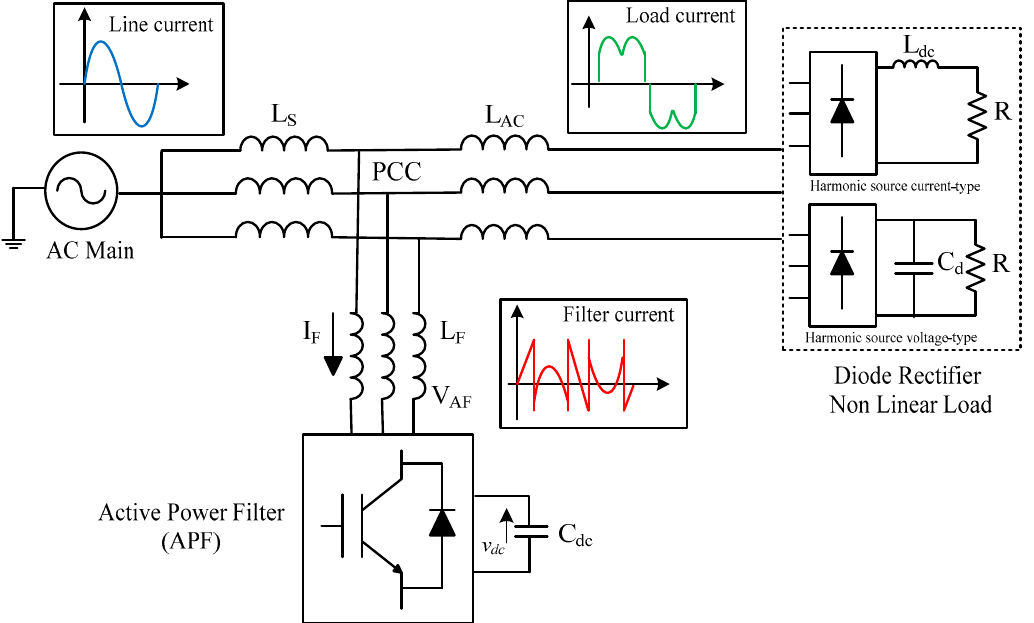
Figure 2. Basic compensation principle of the SAPF.